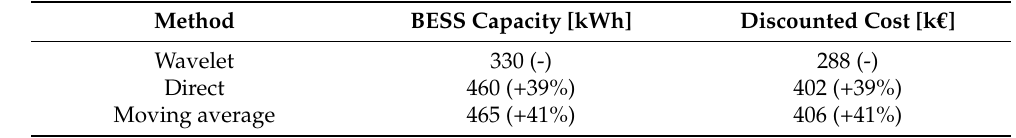
Figure 21. Cost vs. Abatement Ratio for the different methods. Table 9. Discounted lifetime cost comparison between the three methods (AR = 90%).